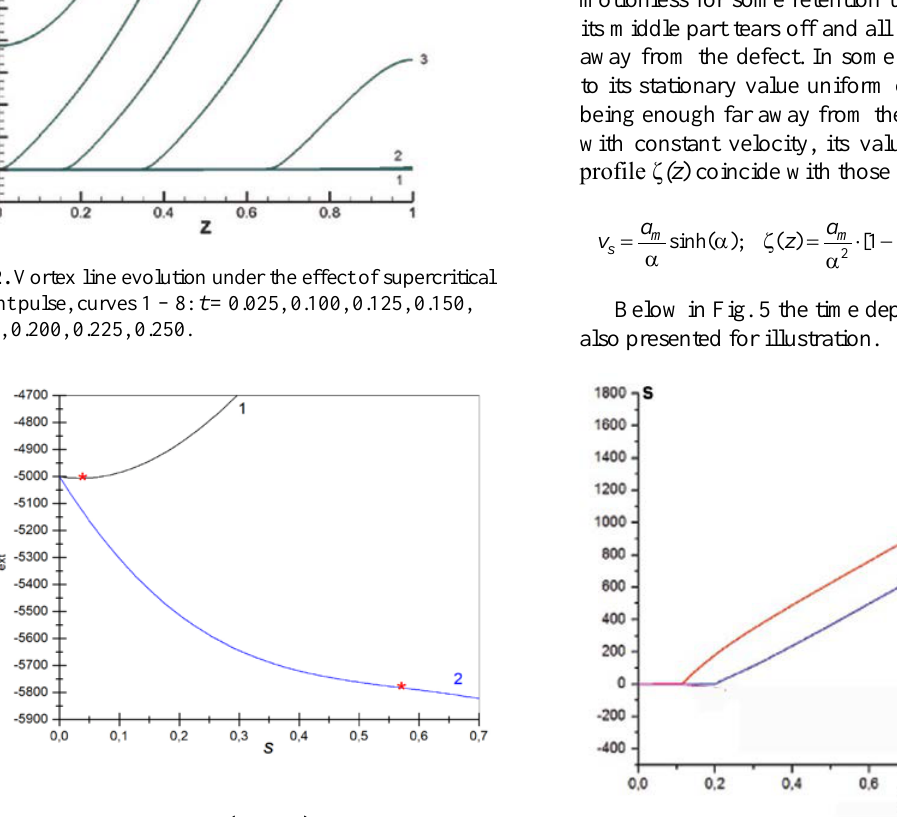
Fig. 5. Time dependence of vortex drift: 1 – s ( t ,1), 2 – s ( t ,0).